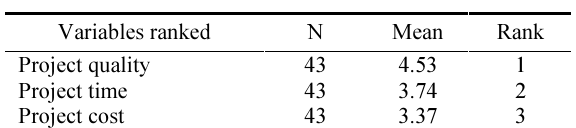
Table 3. Ranking of the levels of importance attached to project cost, time and quality by clients in the award of con- tracts